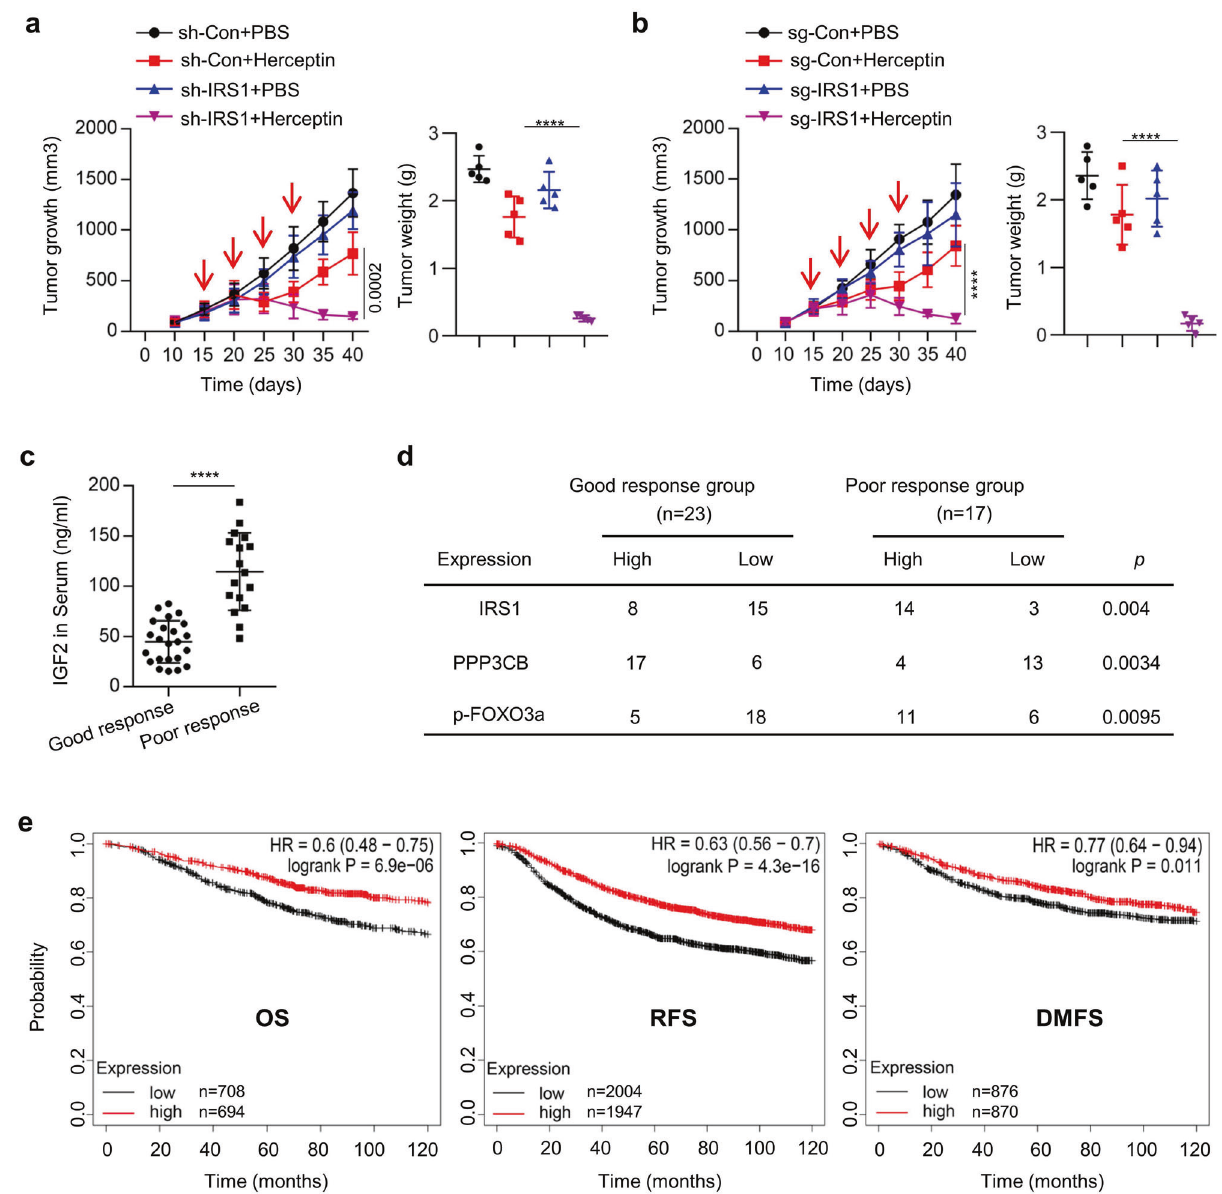
Fig. 7 PPP3CB/FOXO3a/IRS1 signaling contributed to poor response to Herceptin in vivo. a Pool2/sh-Con or pool2/sh-IRS1 cells were subcutaneously inoculated into the armpit of female Balb/C athymic nude mice to generate tumor xenografts. When the tumor size reached ~100 mm 3 , the mice were randomly grouped and received intraperitoneal (i.p.) injection of PBS or Herceptin (10 mg/kg) ( n = 5) once every 5 days. The tumor growth was measured every 5 days (left). At the experimental endpoint, the tumor weights were measured (right), **** p < 0.0001. b Pool2 cells with control sgRNA vector (sg- Con) or IRS1 gene speci fi c sgRNA (sg-IRS1) were subcutaneously inoculated into the armpit of female Balb/C athymic nude mice to generate xenograft tumors. When the tumor sizes reached ~100 mm 3 , the mice were randomly grouped and received i.p. injection of Herceptin (10 mg/kg) or PBS ( n = 5) once every 5 days. The tumor growth was measured every 5 days (left). At the experimental endpoint, the tumor weights were measured (right), **** p < 0.0001. c , d The serum and tumor tissues were obtained from 23 HER2-positive breast cancer patients with a good response to Herceptin-containing treatments and 17 HER2-positive breast cancer patients with a poor response to Herceptin-containing treatments. The levels of IGF2 in the serum were detected by ELISA ( c ), **** p < 0.0001; The expression of IRS1, PPP3CB, and p-FOXO3a in the tumors was examined by Immunohistochemistry (IHC) assays ( d ). Data are presented as mean values ± SEM ( c ). Statistical signi fi cance was determined by a two-tailed Student ’ s t -test ( a – c ). e Kaplan – Meier analyses of overall survival (OS), relapse-free survival (RFS), and distant metastasis-free survival (DMFS) in breast cancer patients with low versus high expression of PPP3CB . The survival curves were shown with the hazard ratio with 95% con fi dence intervals and logrank P Biochemicals (New York, NY, USA). Primary antibodies used in western blot assays: IRS1 (#2382, 1:1000), IGF-1R (#3018, 1:1000), p-IGF-1R(Tyr1131)/IR (Tyr1146) (#80732, 1:1000), Akt (#4691, 1:1000), p-Akt(Thr308) (#13038, 1:1000), p-Akt(Ser473) (#4060, 1:1000), S6K (#2708, 1:1000), p-S6K(Thr389) (#97596,